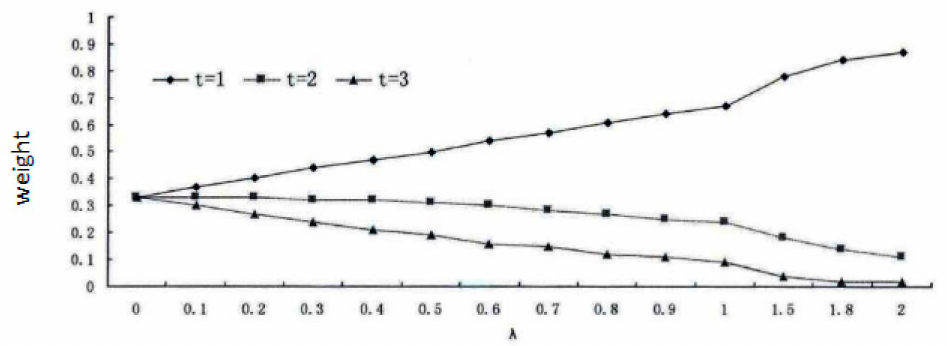
Figure 3. Variations of weight with the parameter λ